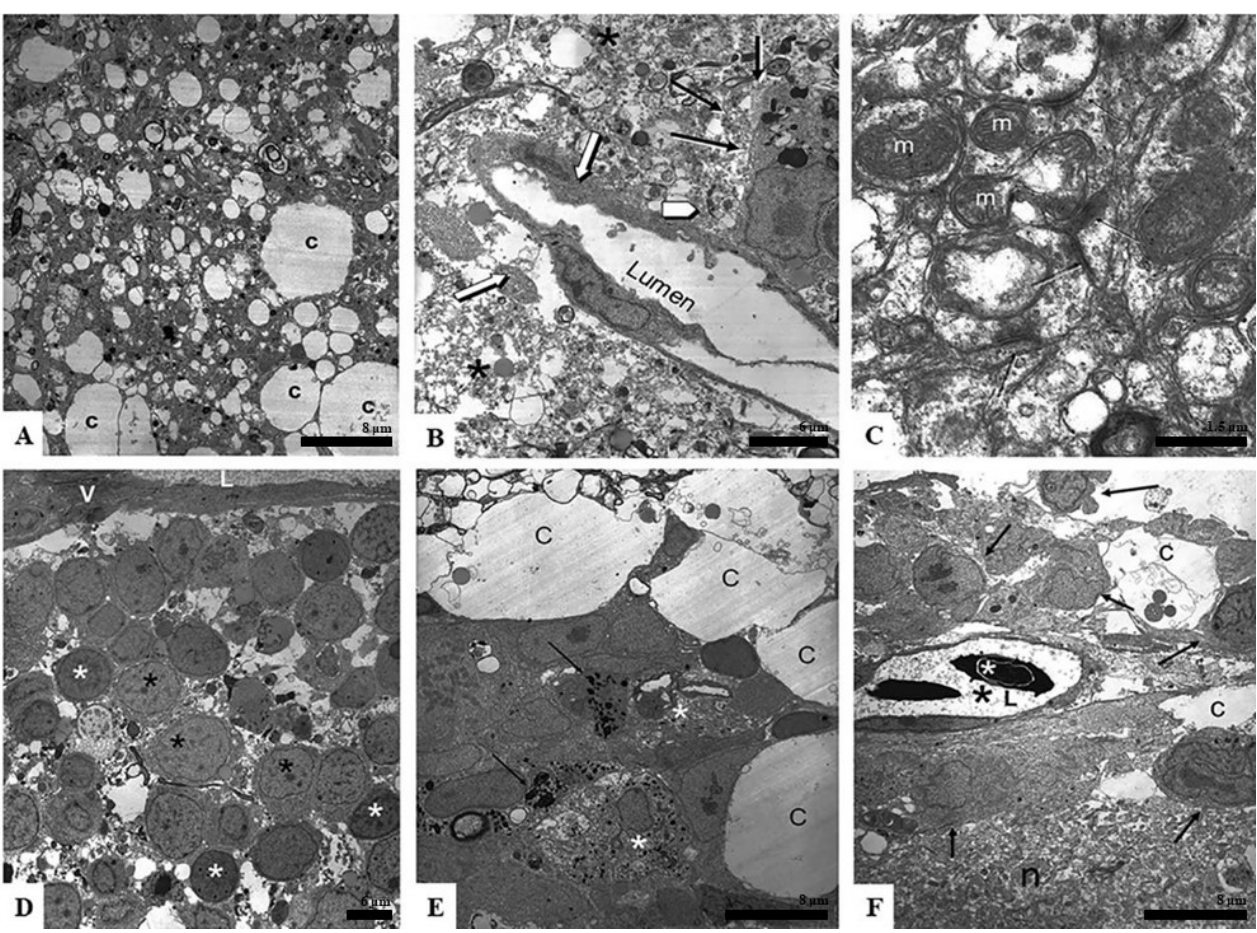
Figure 3. Ultrastructural characteristics of regenerating optic tectum after 96 h in culture. Specifically, ( A ) presents a typical sample of spongiform degenerating tissue with a large number of varying size white spaces, as well as larger cisternal spaces (c). ( B ) shows a surviving blood vessel absent of any blood cells (white arrows). The surrounding area was greatly degenerated (asterisks). The black arrows point to a surviving cell in the area. The white arrowhead points to dense granules. ( C ) shows an area of degrading neuropil. Healthy mitochondria (m) with intact cristae and healthy synapses (black arrows) can be seen. ( D ) is an area of surviving cells that grouped together in a region close to a large vessel seen at the top of the image (V and L). The cells display nuclei of different densities (black asterisk—lighter nuclei; white asterisk—darker nuclei). ( E ) shows an area of early regeneration. Mast cells could be detected (black arrows—granules; asterisk—mast cell body) in this area. The mast cells were surrounded by healthy- appearing cells and cisternae (c). ( F ) shows an area of neuropil (n) that appears more intact than those seen in ( B , C ). One can also see a healthy blood vessel in which new blood cells have formed (white asterisk—red blood cell nuclei; black asterisk—fluid portion of blood vessel; L—lumen of blood vessel). The black arrows are pointing at cells that were active around the vessel.